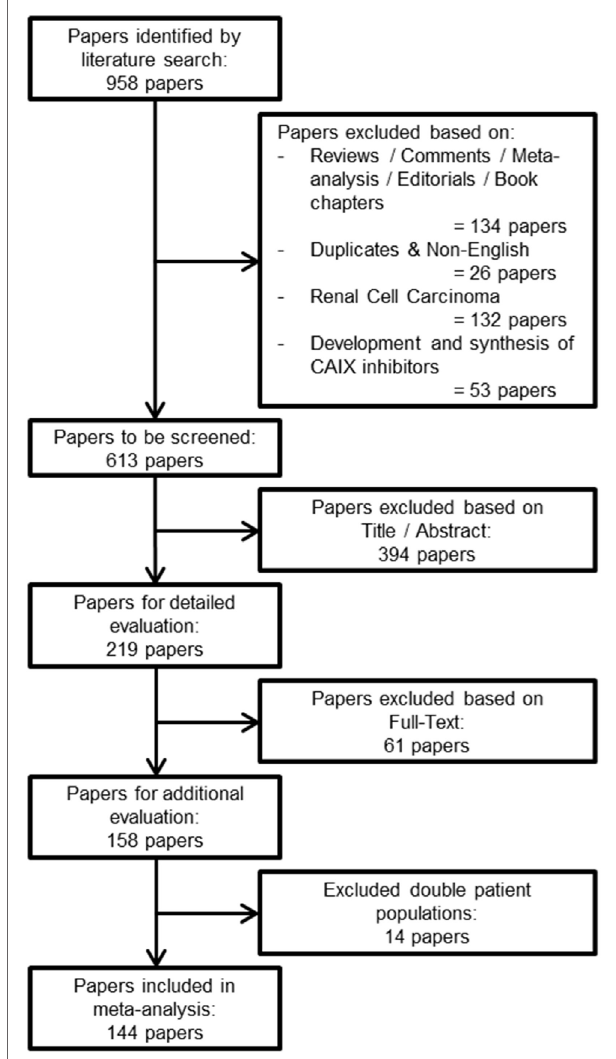
FiGURe 1 | Flowchart of selecting articles describing the association between tumoral CAiX expression and prognosis